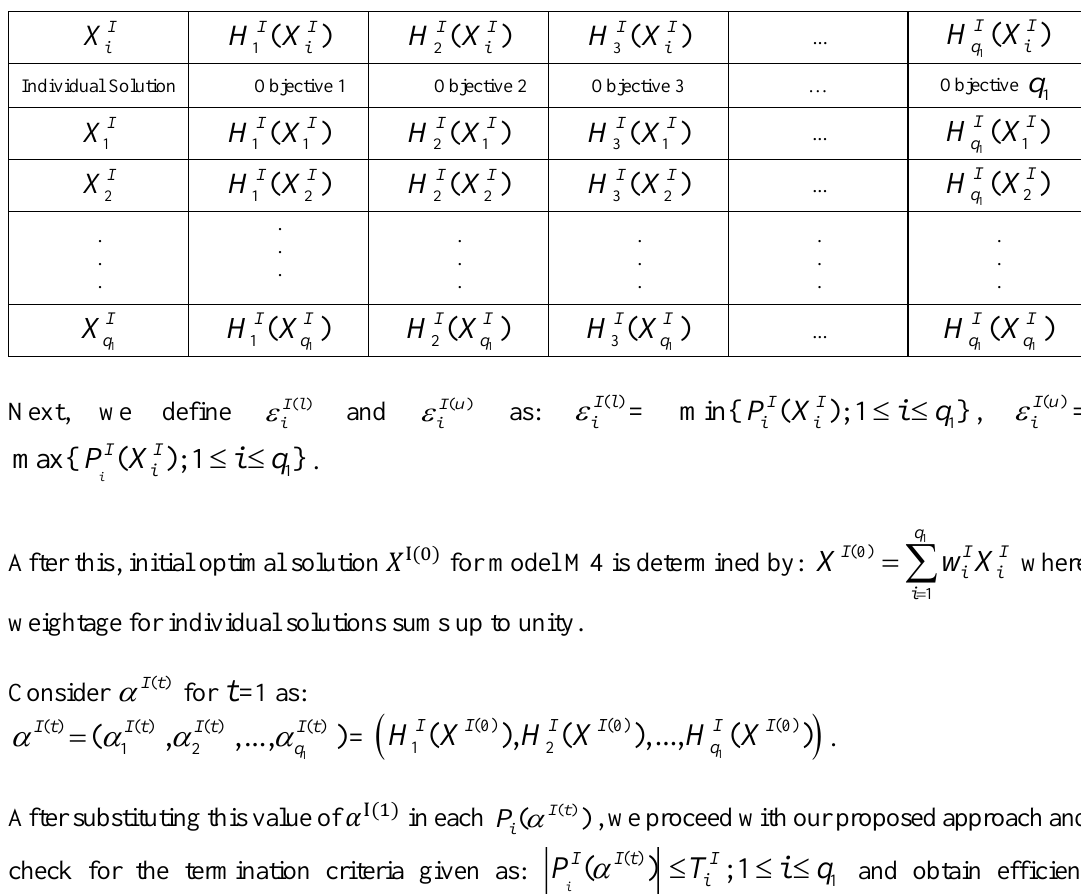
Table 1. Pay-off table for obtaining values of objective